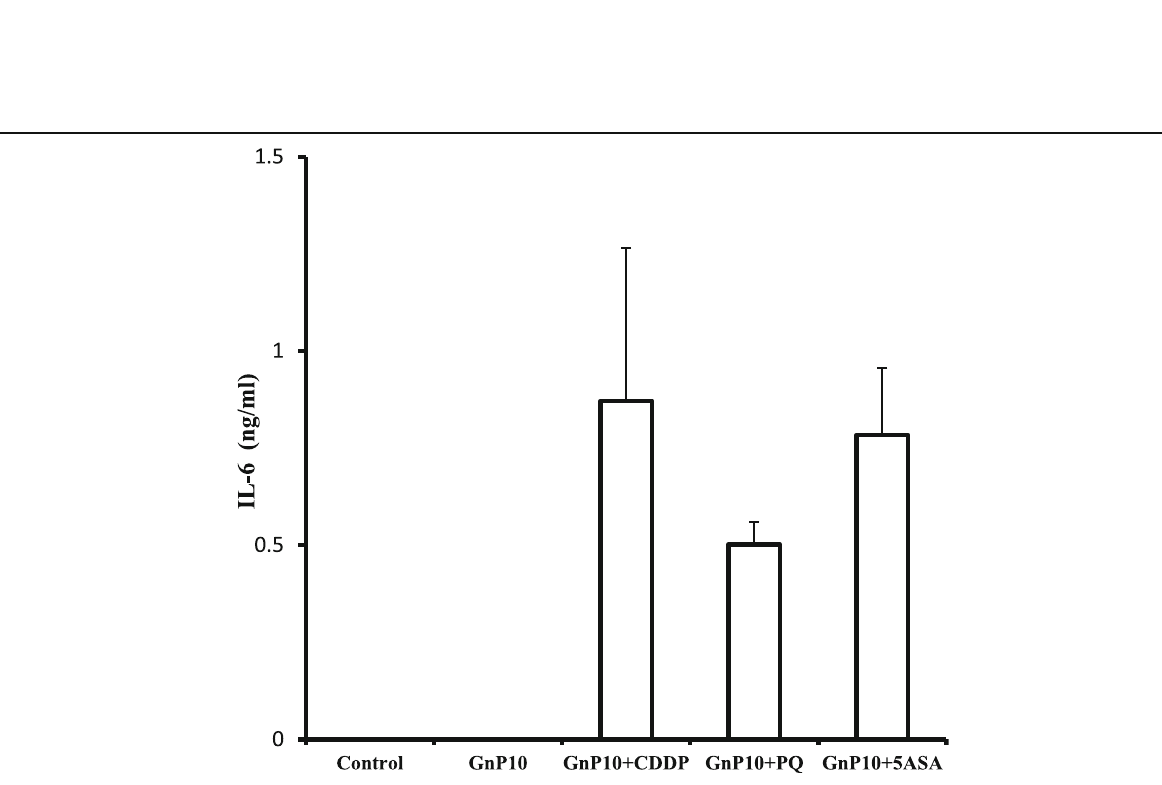
Fig. 6 IL-6 levels in serum, as measured by ELISA. Mice received an IV injection of GnP10 with CDDP, 5-ASA, or PQ. Cytokine levels were measured 3 h after administration. Values are the mean ± standard error (SE; n =